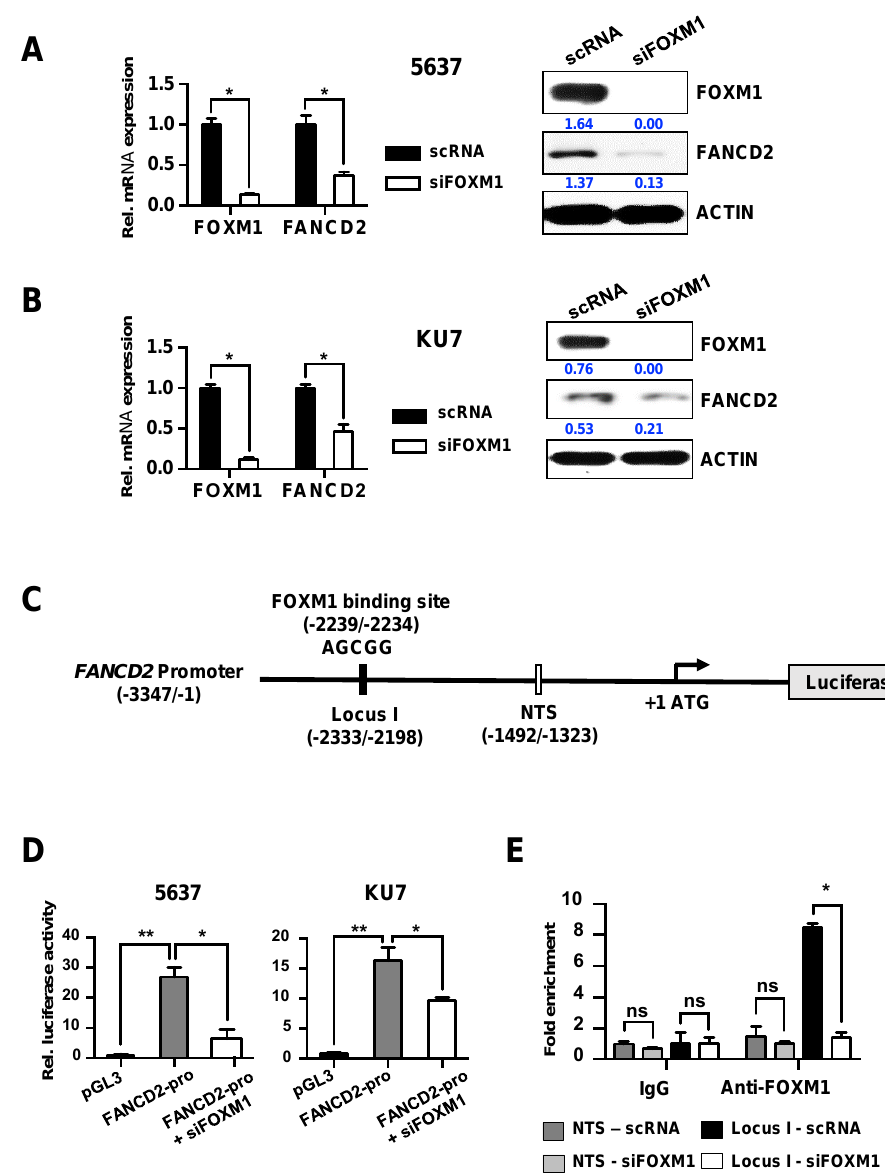
Figure 2. Direct transcriptional regulation of FANCD2 by FOXM1. ( A ) scRNA and siFOXM1 were transfected into 5637 and KU7 cells. mRNA expression was measured using qRT-PCR. ( B ) FOXM1 and FANCD2 protein expression was measured by Western blot in scRNA- and siFOXM1-transfected 5637 and KU7 cells. ( C ) A schematic diagram of the FANCD2 promoter region ( − 3347 / − 1). The black bar represents the putative FOXM1 binding site ( − 2239 / − 2234) and the qChIP amplification locus ( − 2333 / -2198). The white bar represents the nontarget sequence of the qChIP amplification locus ( − 1492 / − 1323). ( D ) FANCD2 promoter activity was measured using a luciferase assay in siRNA (scRNA or siFOXM1)-transfected BC (Bladder cancer) cells. pGL3 vector was used as a control. ( E ) FOXM1 binding a ffi nity of the FANCD2 promoter region. siRNA or siFOXM1 was transiently transfected into KU7 cells and immunoprecipitated using FOXM1 antibody and rabbit IgG (control). The amount of chromatin was measured using qRT-PCR along with a target site primer (I) and a nontarget site (NTS) primer. (*, p < 0.05; **, p < 0.01; and ns, not